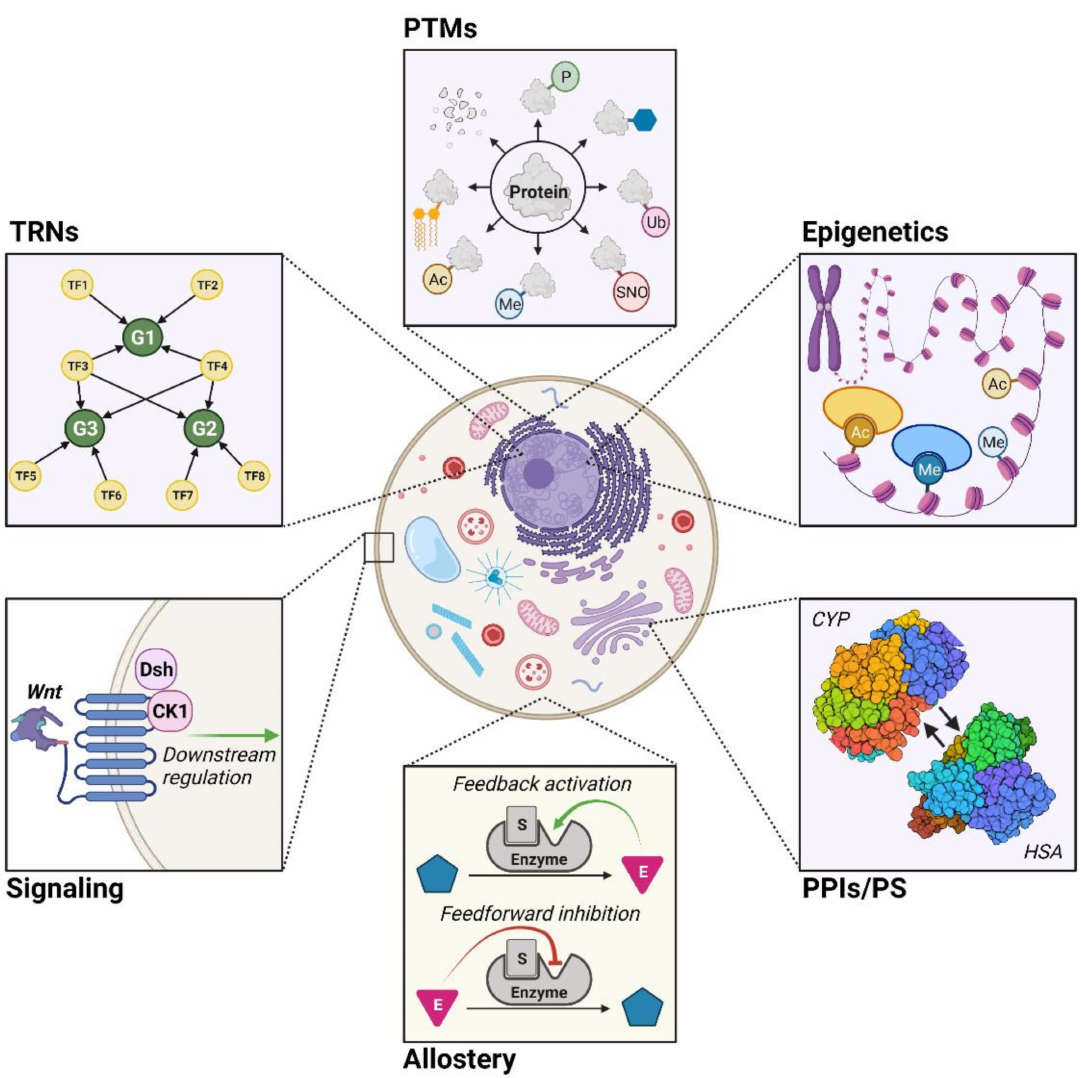
Figure 1. Six regulatory mechanisms that influence metabolism (bolded). TRNs : transcriptional regulatory networks, which describe how gene transcription is regulated (depicted: general TRN); PTMs : post-translational modifications, where proteins are enzymatically modified following their translation (depicted: phosphorylation (P), glycosylation, ubiquitination (Ub), S-nitrosylation (SNO), methylation (Me), N-acetylation (Ac), lipidation, proteolysis); epigenetics , which involve changes in gene expression without alterations the DNA itself (depicted: histone acetylation (Ac) and histone methylation (Me)); PPIs/PS: protein–protein interactions and protein stability, where functionality depends on direct protein–protein contact and their structural integrity (depicted: interactions between cytochrome P450 monooxygenase (CYP) and human serum albumin (HSA)); allostery , or the regulation of protein activity from non-active site ligand binding (depicted: general allosteric regulatory events); and signaling , which entails how signaling pathways govern the activity of a cell (depicted: Wnt signaling